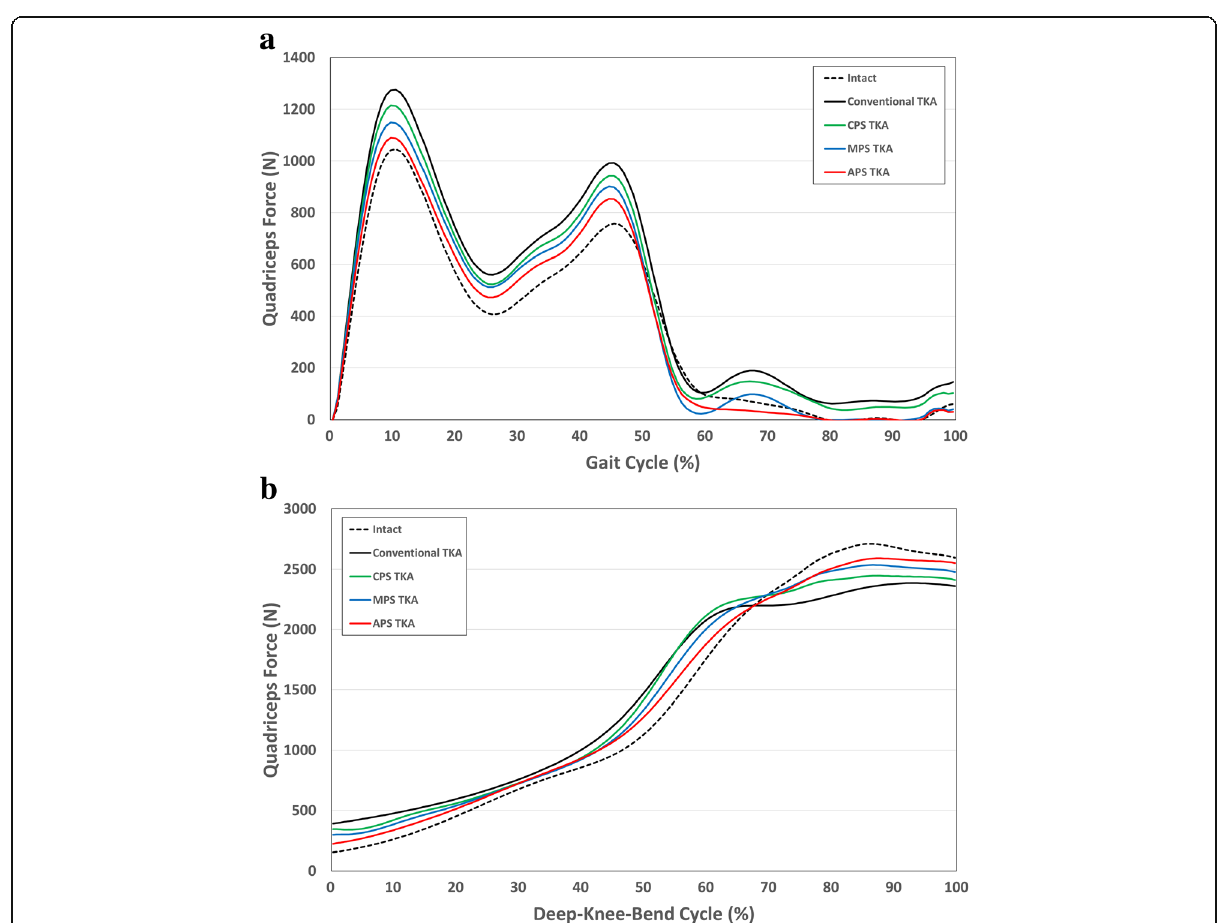
Fig. 6 Comparison of quadriceps force between conventional TKA and three different conformity of patient-specific TKA (CPS TKA, MPS TKA, APS TKA) during a gait and b deep-knee-bend